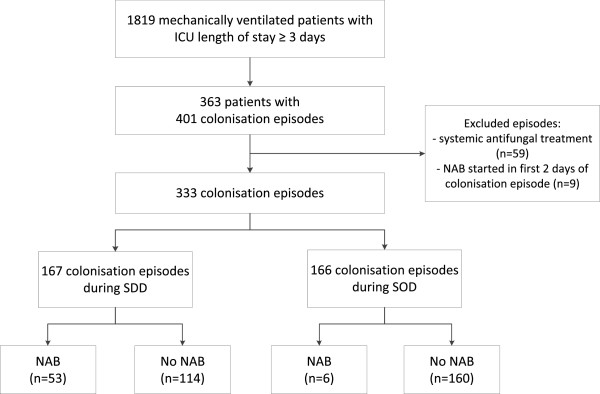
Patient inclusion.